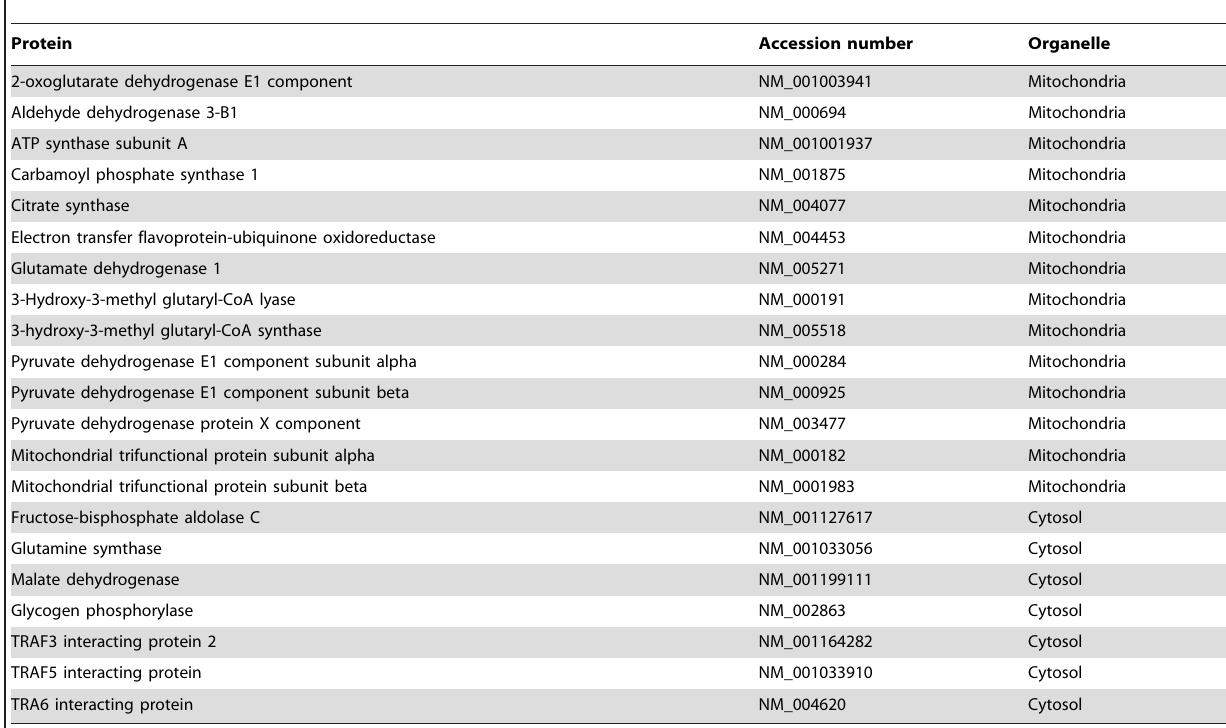
Table 1. Proteins associated with SCHAD using Yeast-2 Hybrid analysis.